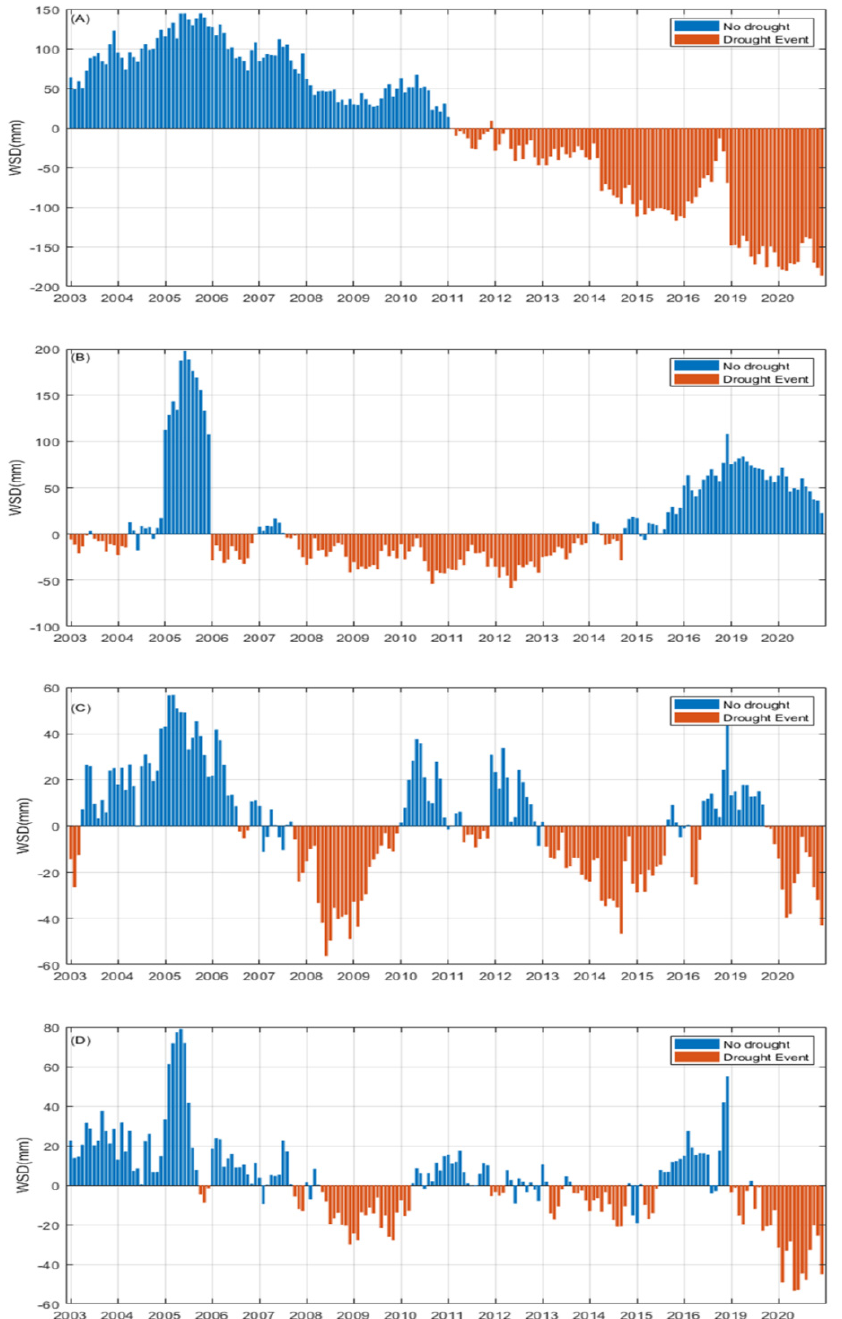
Figure 4. Statistics of the WSD and drought events near the ( A ) Caspian Sea, ( B ) Kazakh Hills, ( C ) Moynkum Desert, and ( D ) Gurbantünggüt Desert in arid regions of central Asia from 2003 to 2020.